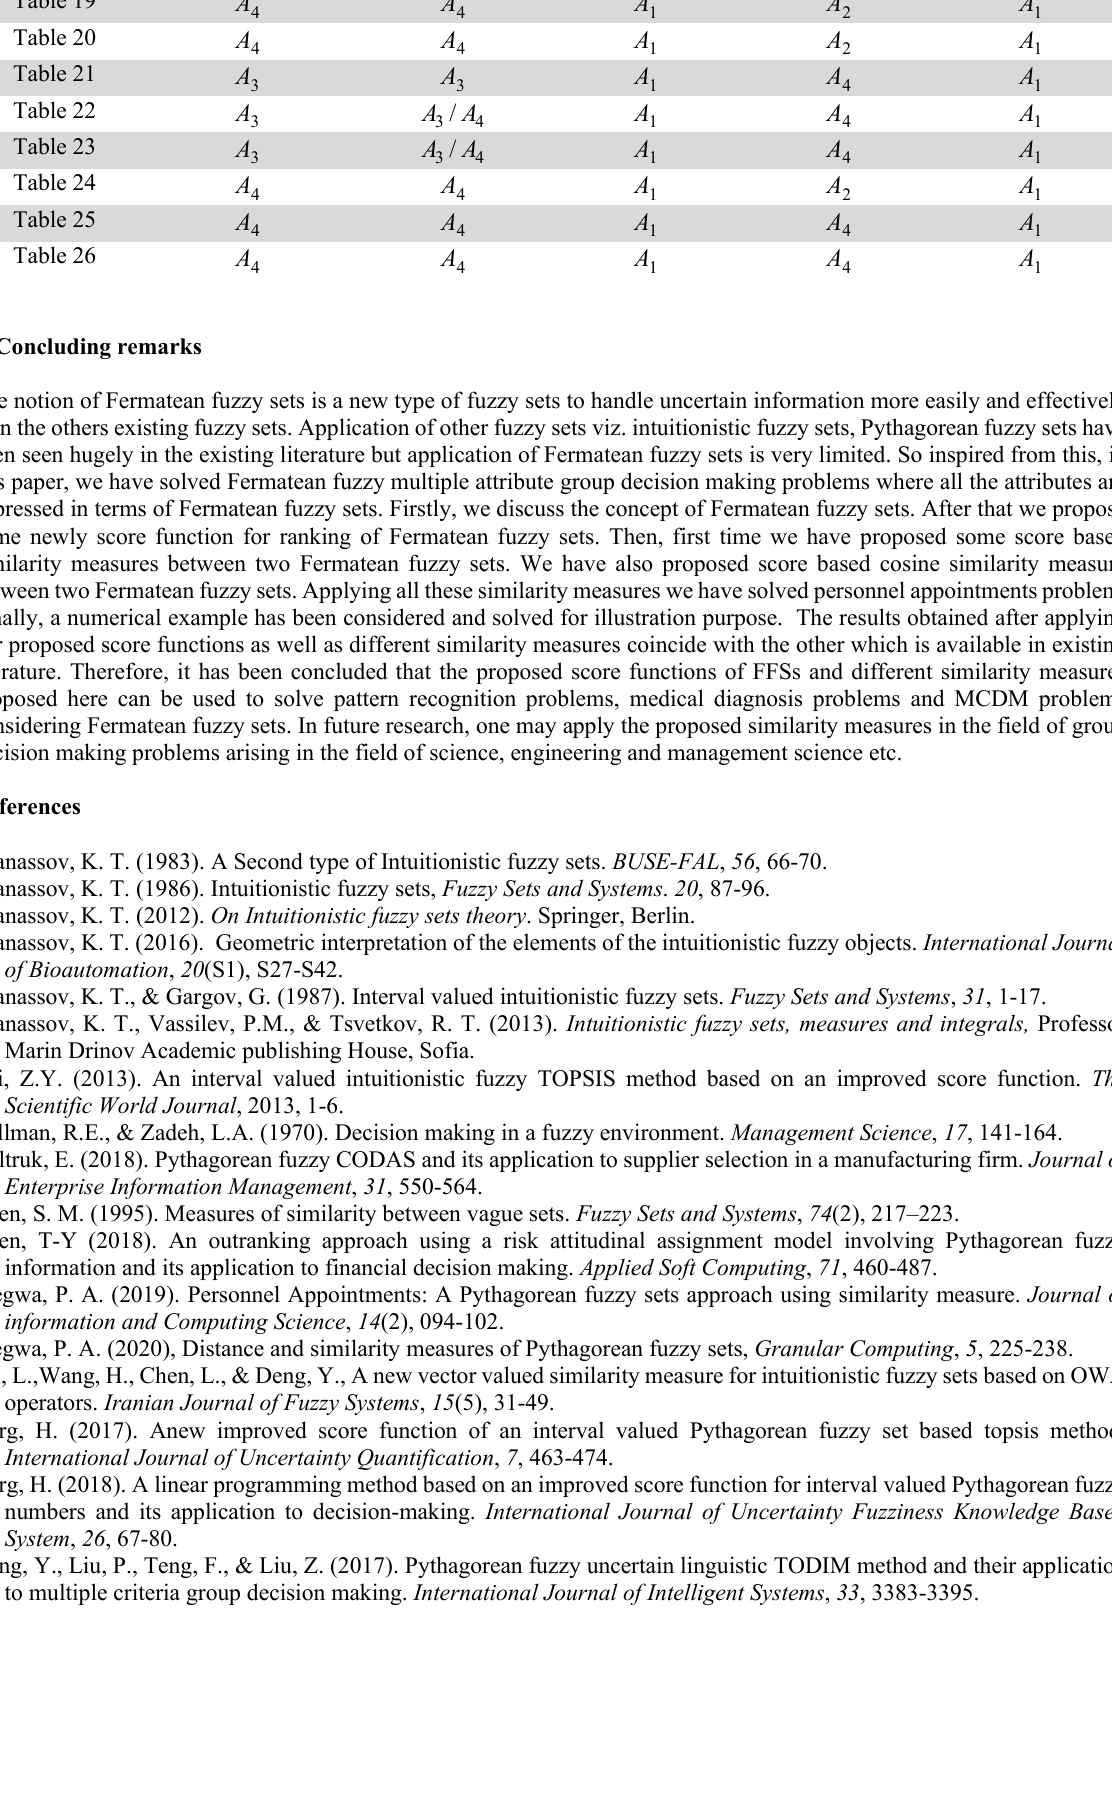
A 1 A 1 A 1 A 1 A 1 A 1 A 1 1